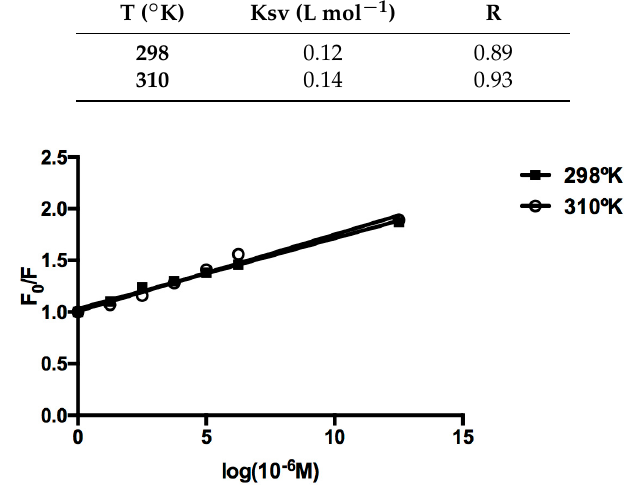
Figure 5. Plot of log(F 0 − F)/F versus log[Q] for the Molybdenum [Mo 6 Cl 14 ] 2 − clusters-albumin system.